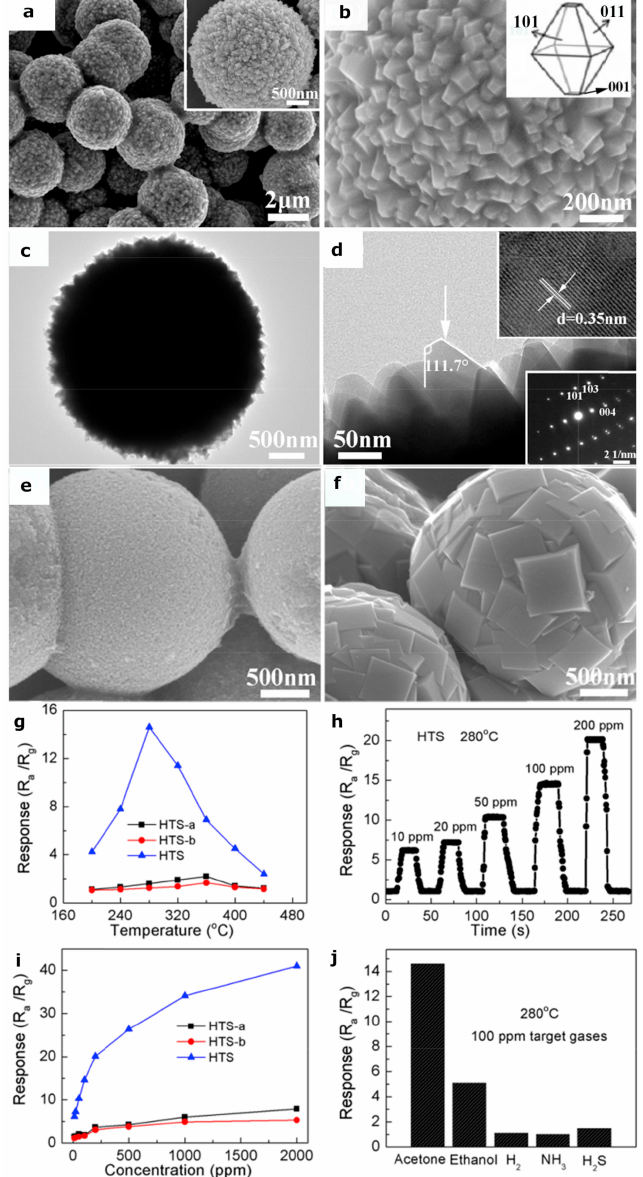
Figure 8. ( a , b ) FESEM images and ( c , d ) TEM image of HTS; ( e ) FESEM images of HTS-a; ( f ) HTS-b; ( g ) Response of three TiO 2 sensors versus various working temperatures to 100 ppm acetone; ( h ) Gas response of HTS under different concentrations of acetone at 280 ◦ C; ( i ) Response of the three TiO 2 sensing materials to 10–2000 ppm of acetone; ( j ) Selectivity of HTS for the detection of 100 ppm of various target gases, Reprinted from Ref. [139] with the permission of Elsevier Ltd.,